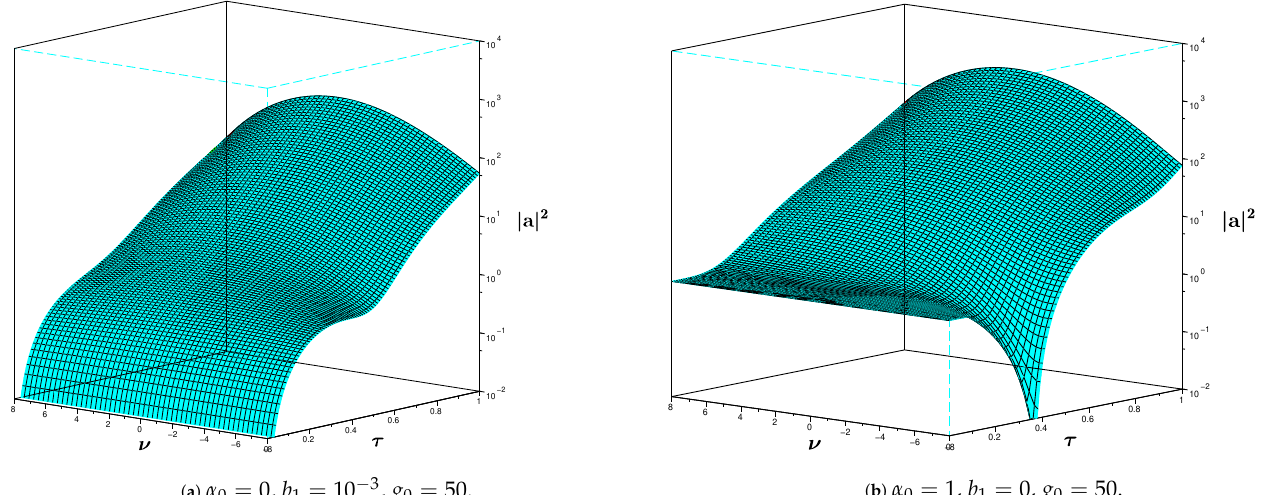
Figure 2. Intensity vs. detuning ν 0 and dimensionless time τ